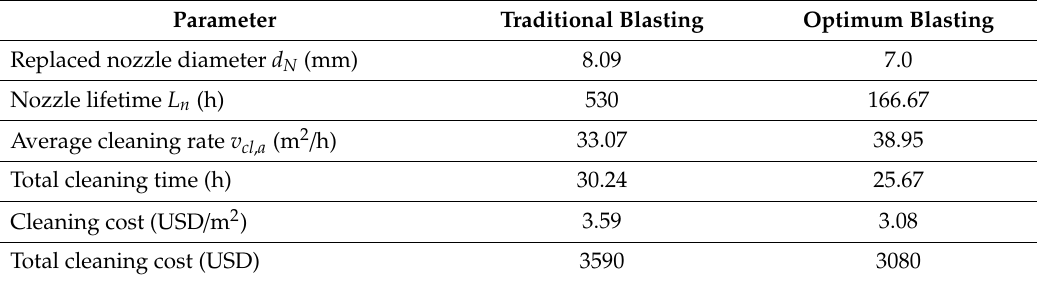
Table 5. Example calculated